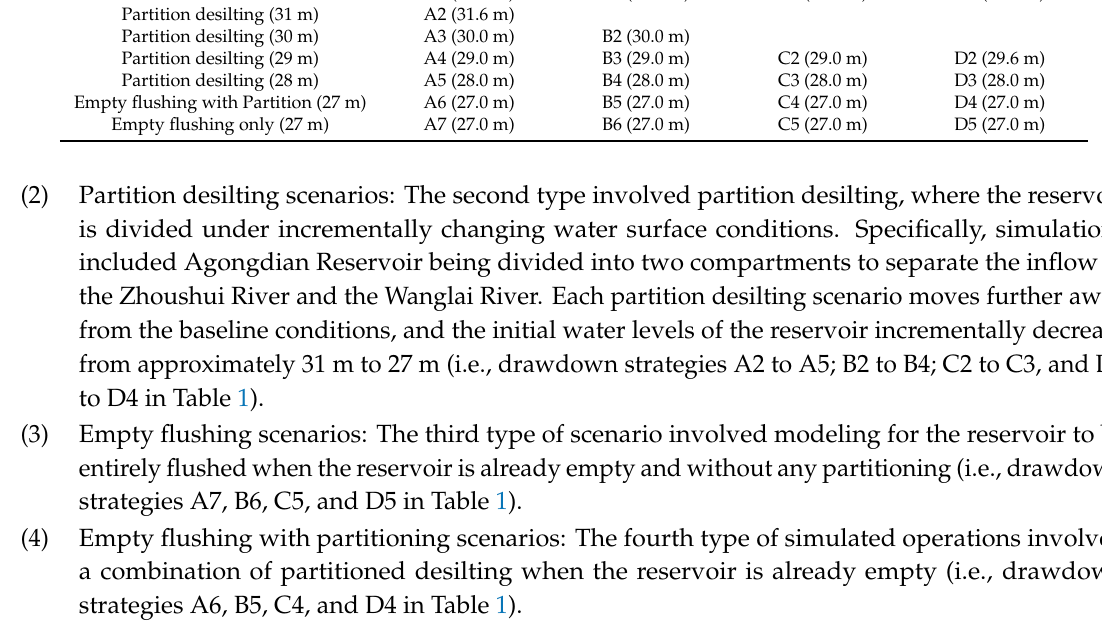
Typhoon Event Fanapi Talim Trami